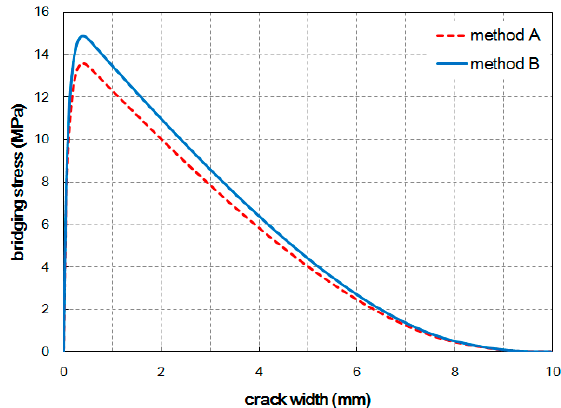
Figure 8. Tensile bridging behaviors estimated from the image analysis results.